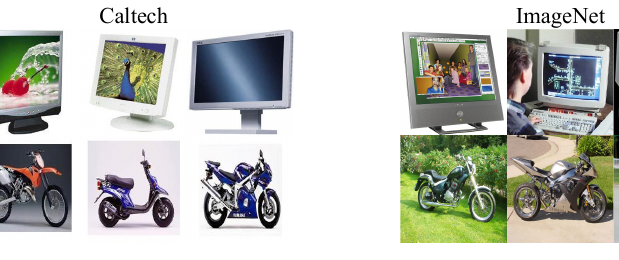
Figure 2. Objects in different